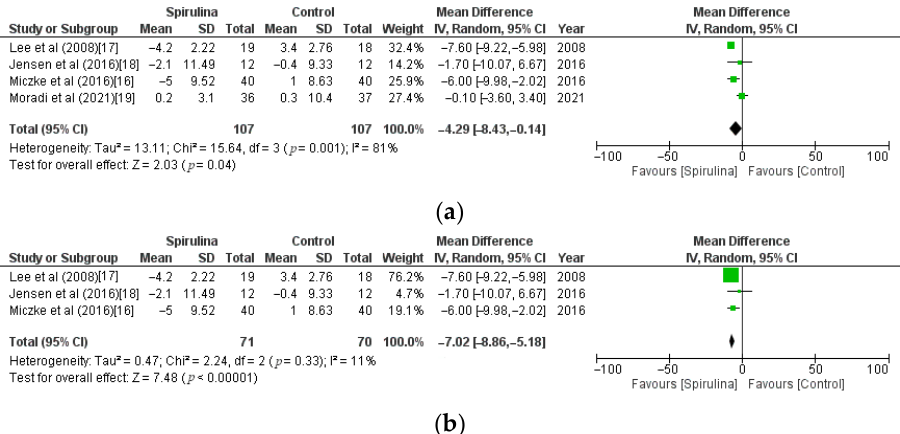
Figure 7. ( a ). Effect of Spirulina supplementation on systolic blood pressure (SBP) compared with the